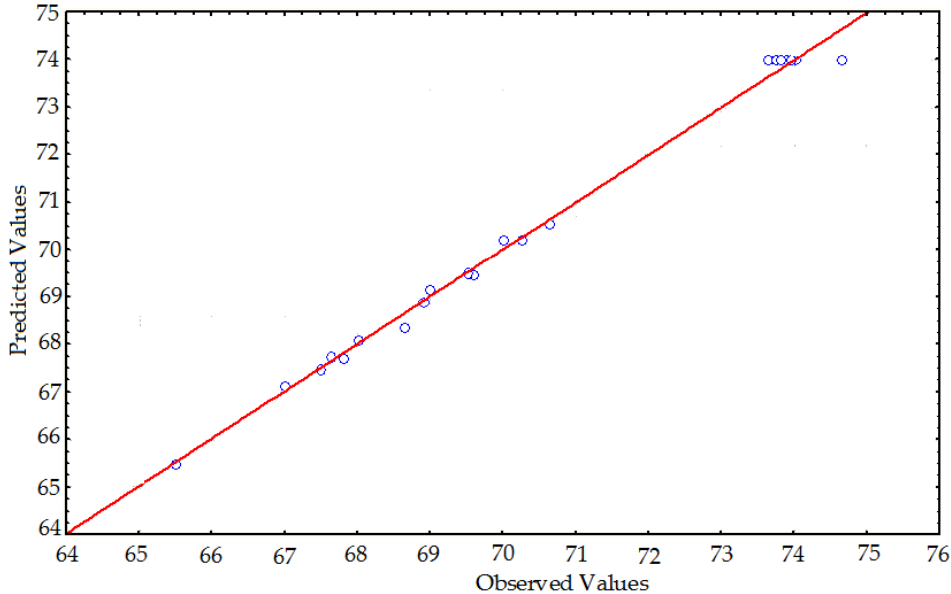
Figure 13. Predicted values vs. observed values plot for the CEC.